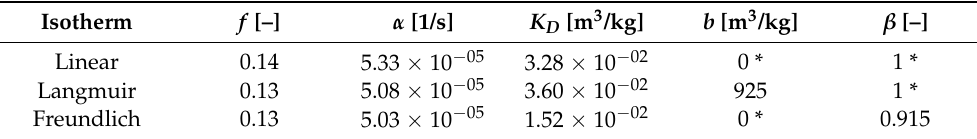
Table 3. Fitted chemical nonequilibrium transport parameters derived from the two-site model for the breakthrough curves and different adsorption isotherms shown in Figure 3. Parameters highlighted with * were predefined and not